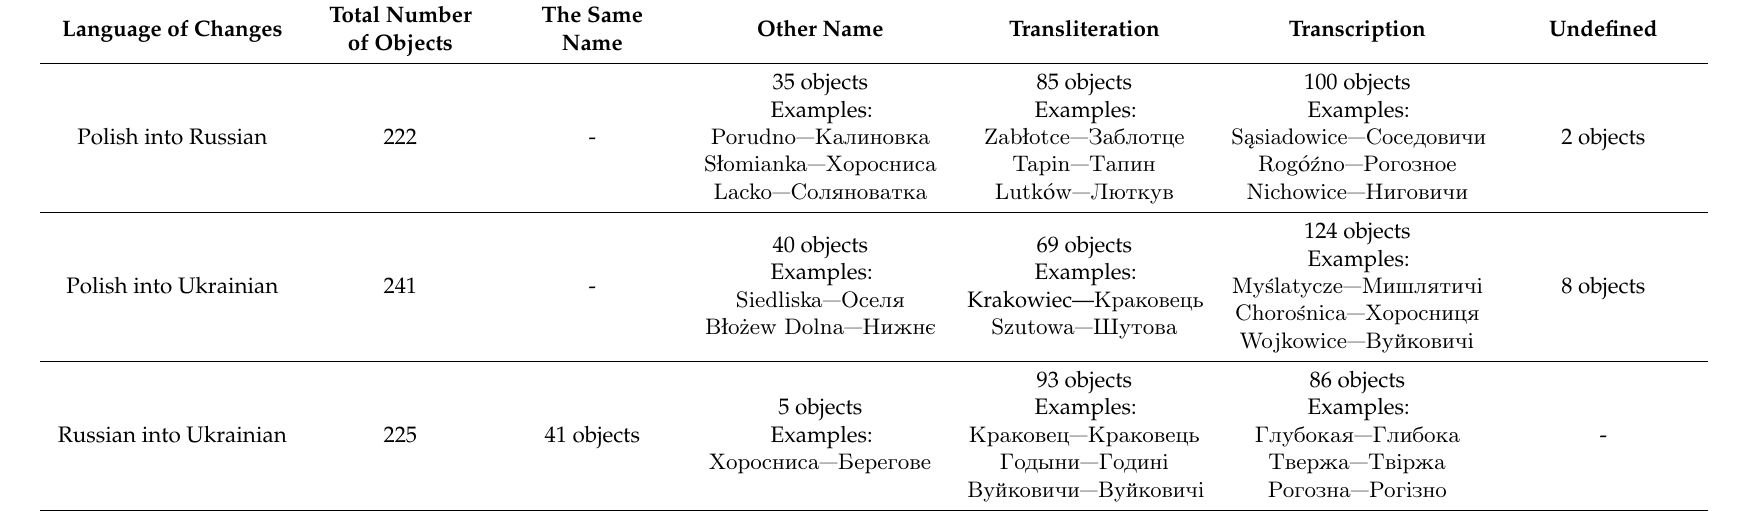
Table 2. Rules for naming variations between Polish, Russian, and Ukrainian names (source: own study). Total Number Language of Changes of